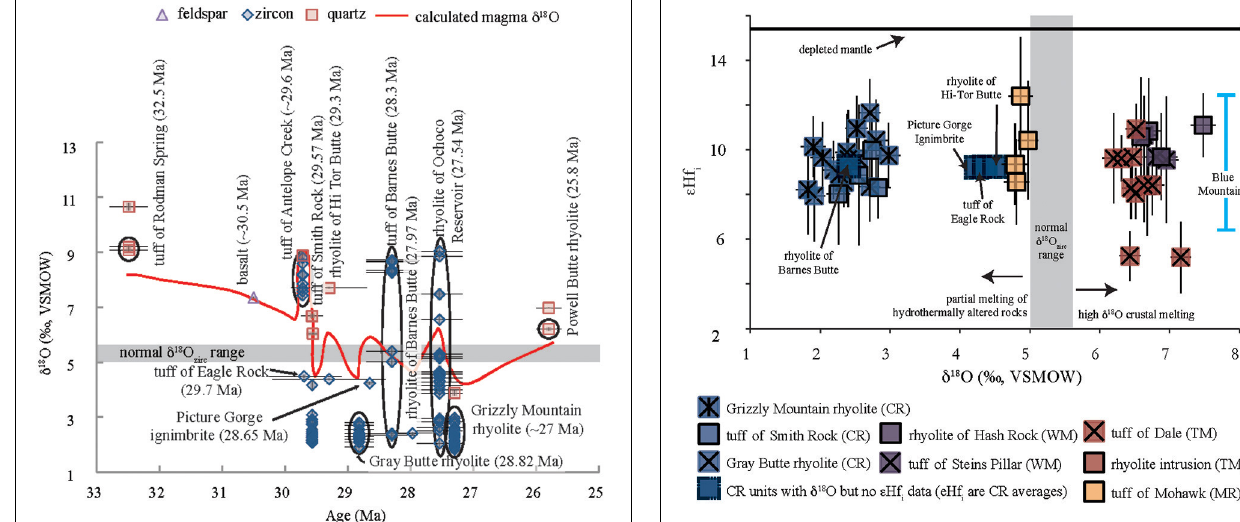
FIGURE 5 | δ 18 O vs. age for zircon, feldspar, and quartz associated with the Crooked River caldera. Ages are from this work and previous studies (listed in the Supplementary Material). The low δ 18 O zircon values of the Crooked River caldera are contrasted by the high δ 18 O zircon values of the Tower Mountain ( Figure 4 ) and Wildcat Mountain ( Figure 3 ) calderas. See Figure 3 for other symbols and explanations.